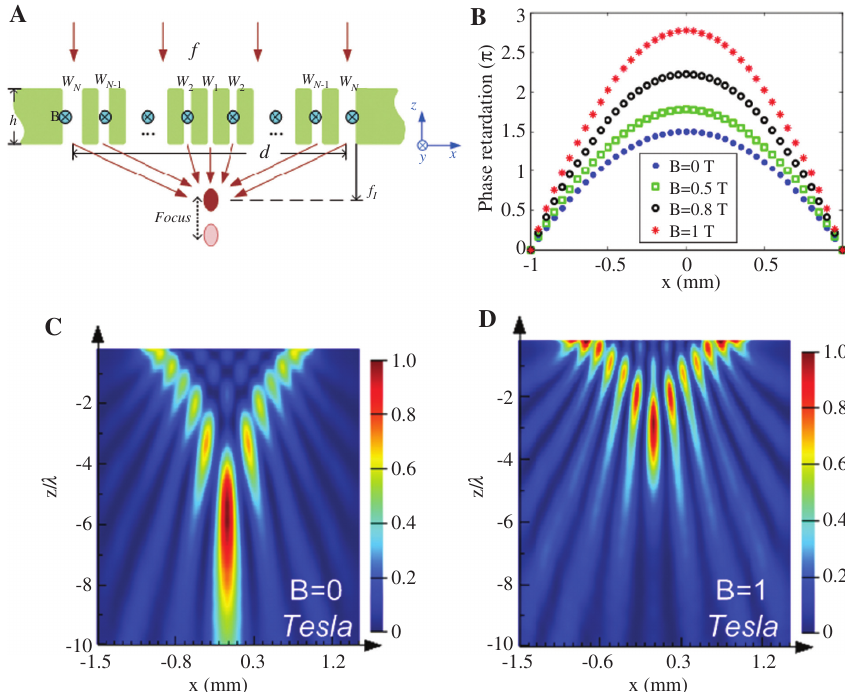
Figure 7: A tunable plasmonic lens (from [74]). (A) Schematic structure of the lens. The structure consists of an InSb slab tunable by an external magnetic field B , and perforated with 2 N -1 sub-wavelength slits. (B) The relative phase retardation of the slits under mag- netic fields of 0, 0.5, 0.8 and 1 Tesla. (C), (D) Field distributions of the structure when the external magnetic field is 0 Tesla and 1 Tesla, respectively.